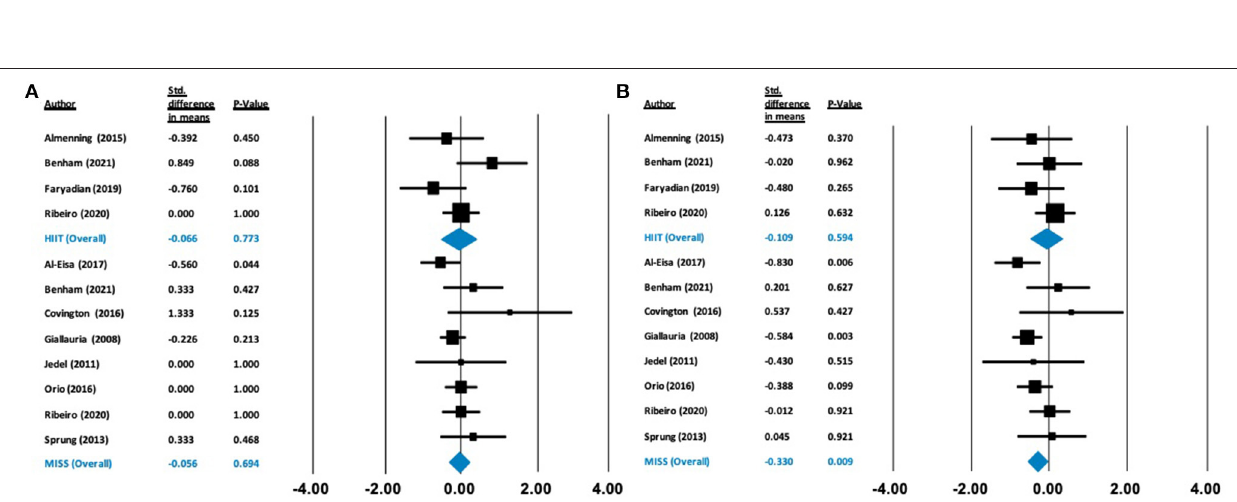
confidence intervals for: (A) fasting glucose, (B) fasting insulin as measures of cardiometabolic ±